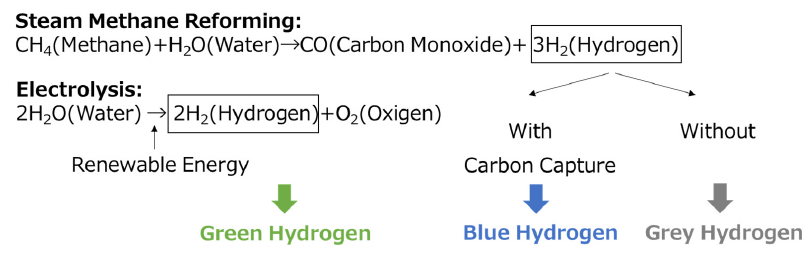
Figure 1. Hydrogen classifications.